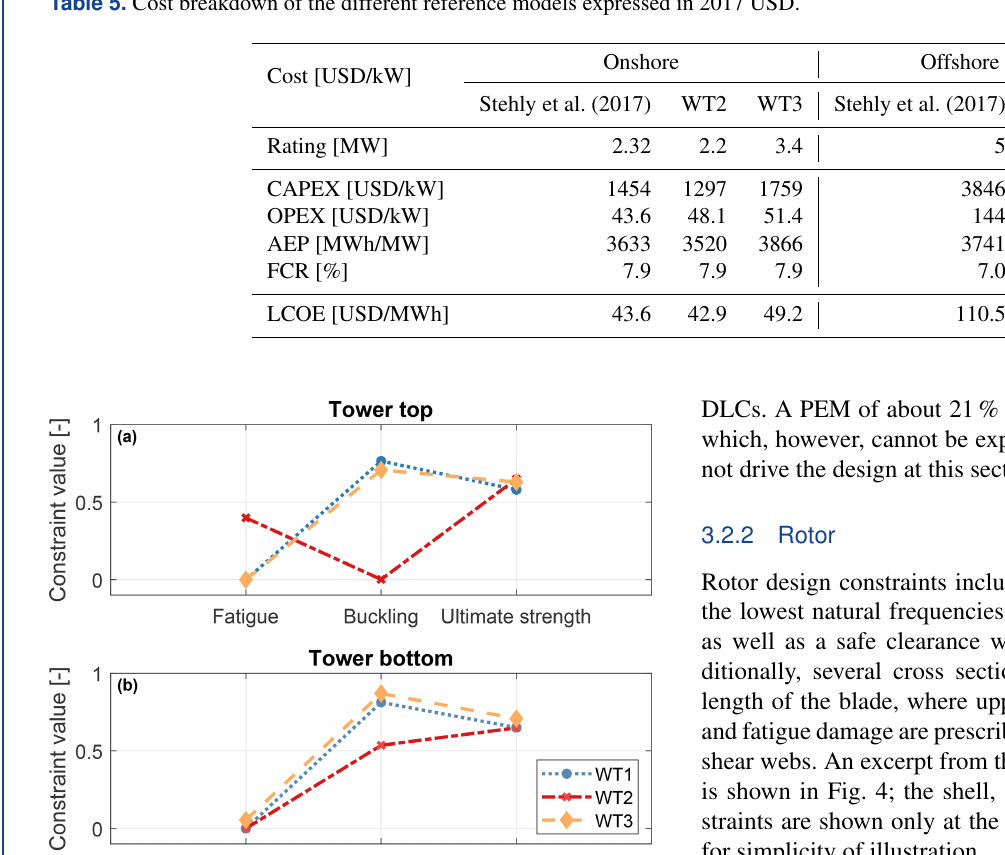
Table 5. Cost breakdown of the different reference models expressed in 2017 USD.